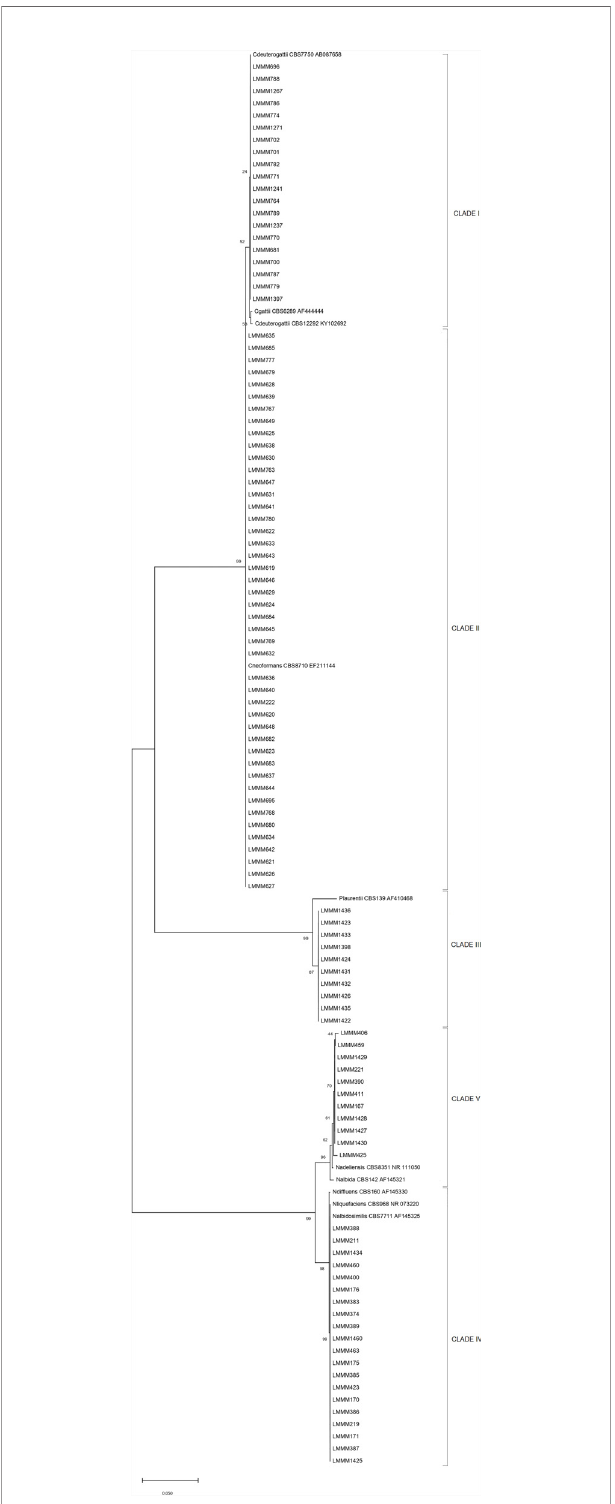
FIGURE 1 | Neighbor-Joining phylogenetic tree of rDNA ITS sequences from 106 clinical and environmental isolates and 10 type strain sequences from Cryptococcus spp. and associated genera. Bootstrap values are depicted in all nodes (bt). The scale bar represents the number of base substitutions per